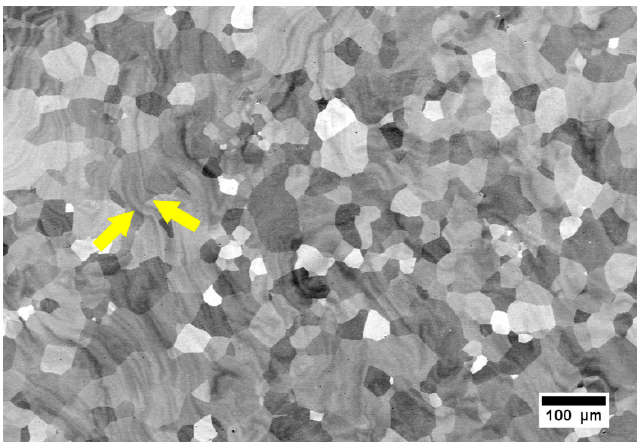
Figure 1. Scanning electron microscopy–back-scattered electrons (SEM–BSE) micrograph of the solution-treated (ST) Ti15Mo alloy (the yellow arrows indicate chemical inhomogeneities in the material). Table 1. Chemical composition of the darker and brighter bands (marked by yellow arrows in Figure 1) as determined by energy dispersive spectroscopy (EDS) point analysis. Element Brighter Part (wt.%)